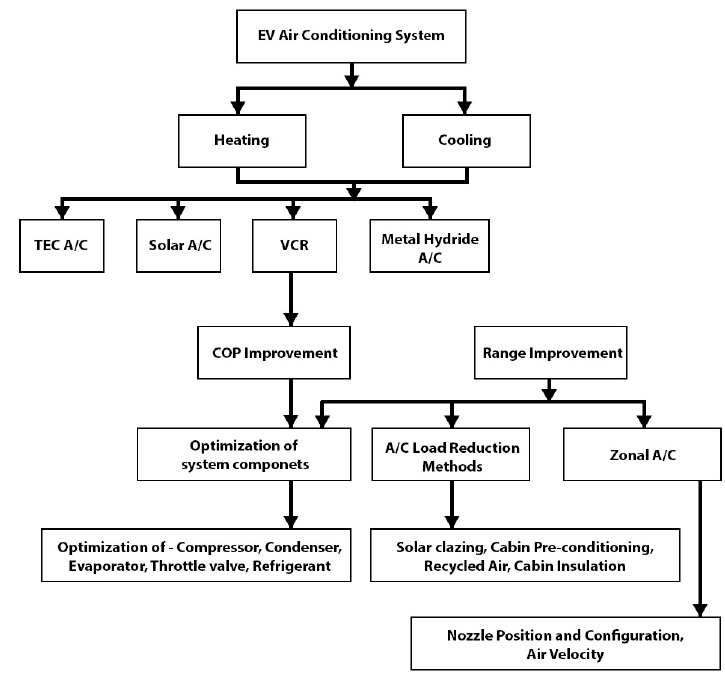
Figure 1. The layout of the review paper.